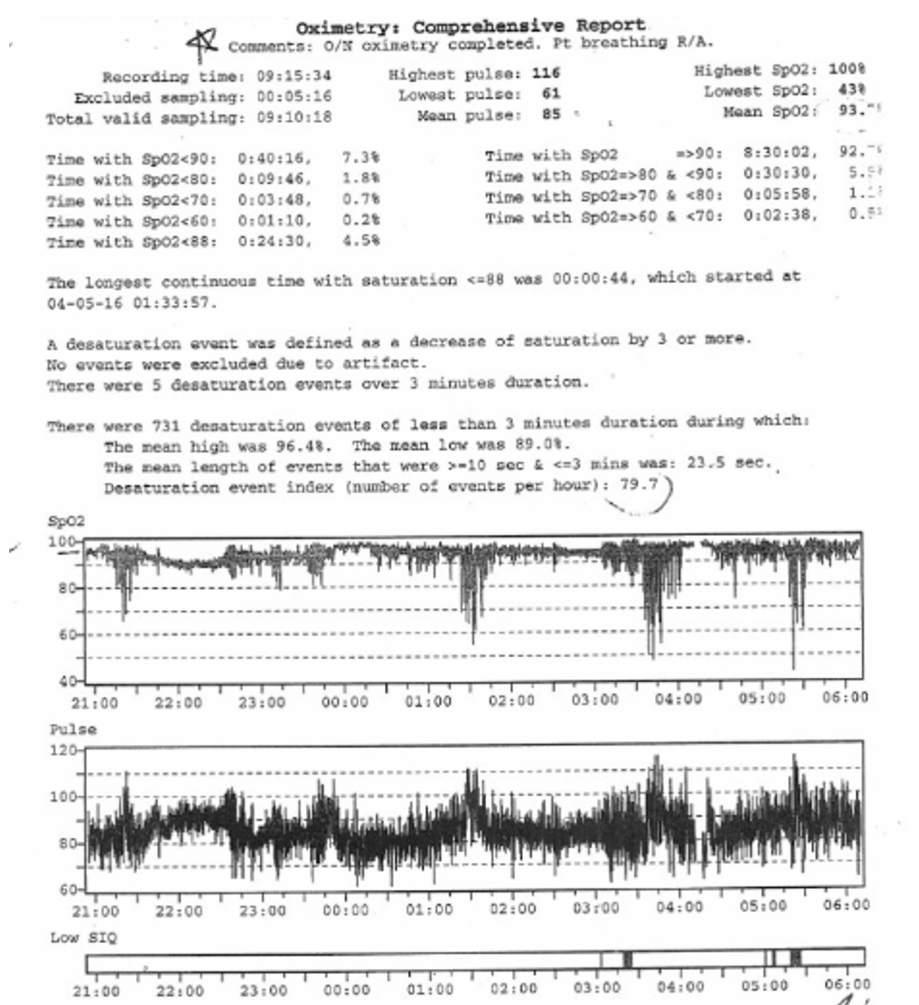
Figure 4. Overnight oximetry demonstrating the characteristic “sawtooth pattern” of oxygen desaturations suggestive of obstructive sleep